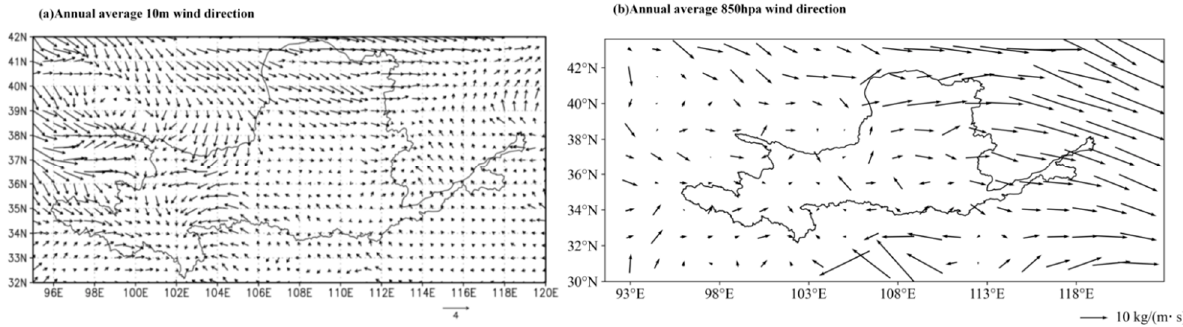
Figure 6. Annual average map of 10 m and 850 hPa wind directions in the Yellow River Basin from 1980 to 2019. (( a ): Annual average 10m wind direction; ( b ): annual average 850hpa wind direction).